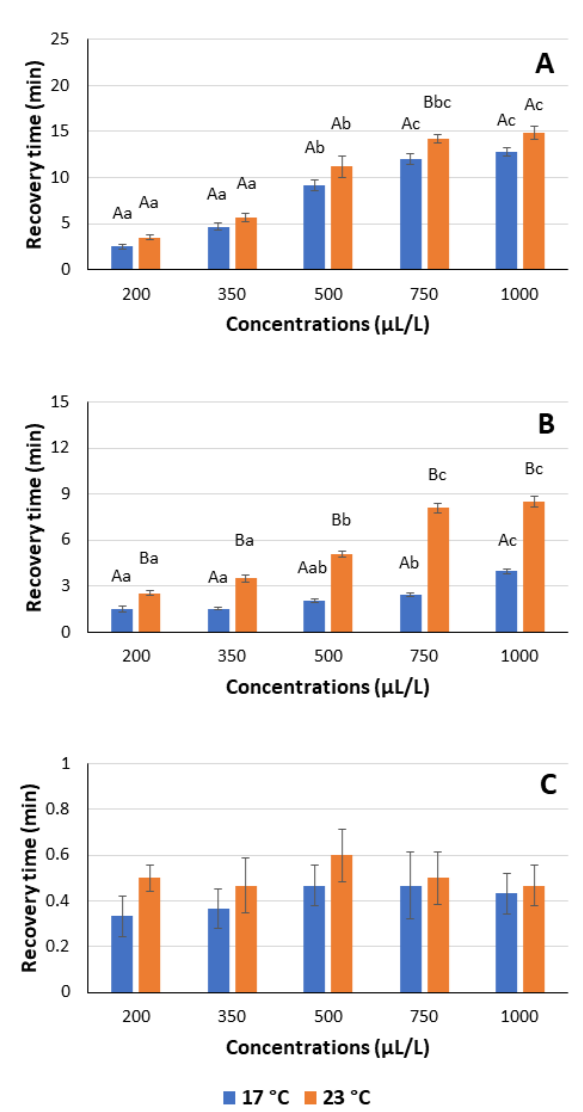
Figure 3. Recovery times (min) for three different plant-based essential oils used as a natural anesthetic for red swamp crayfish. (A) Clove oil (in two-way ANOVA, p = 0.0000 for concentration, p = 0.0003 for temperature and p = 0.7499 in interaction); (B) spearmint oil (in two-way ANOVA, p = 0.0000 for concentration, p = 0.0000 for temperature, and p = 0.0000 in interaction); (C) chamomile oil (in two-way ANOVA, p = 0.7585 for concentration, p = 0.1642 for temperature, and p = 0.9511 in interaction). Different uppercase letters indicate significant differences between temperatures at the same concentration. Different lowercase letters indicate significant differences between concentrations at the same temperature ( p <